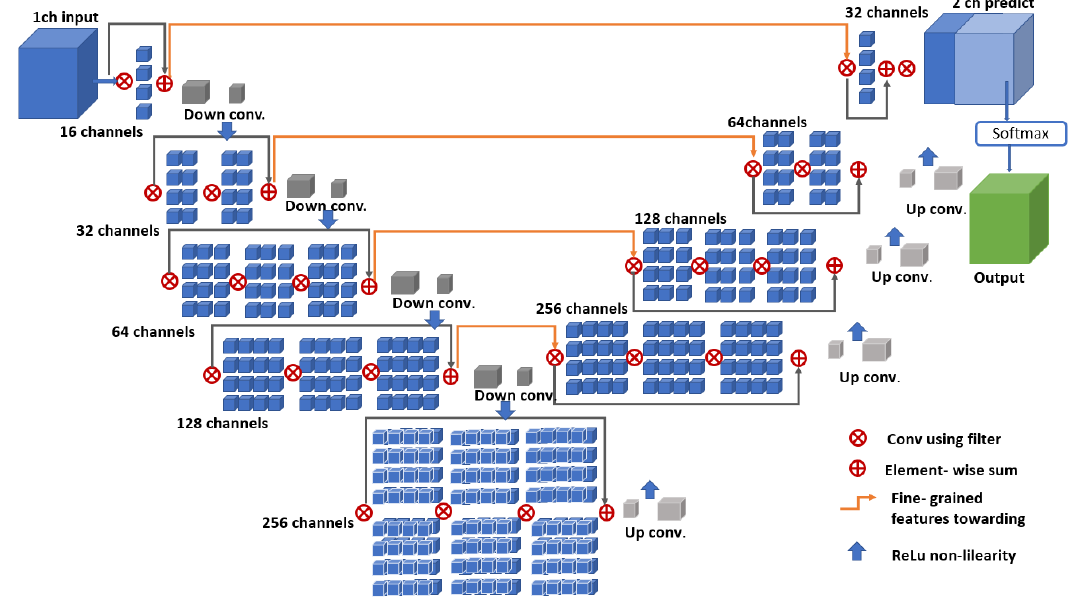
Figure 3. Schematic representation of the V-Net architecture consisting of encoder and decoder phases with a classical structure.